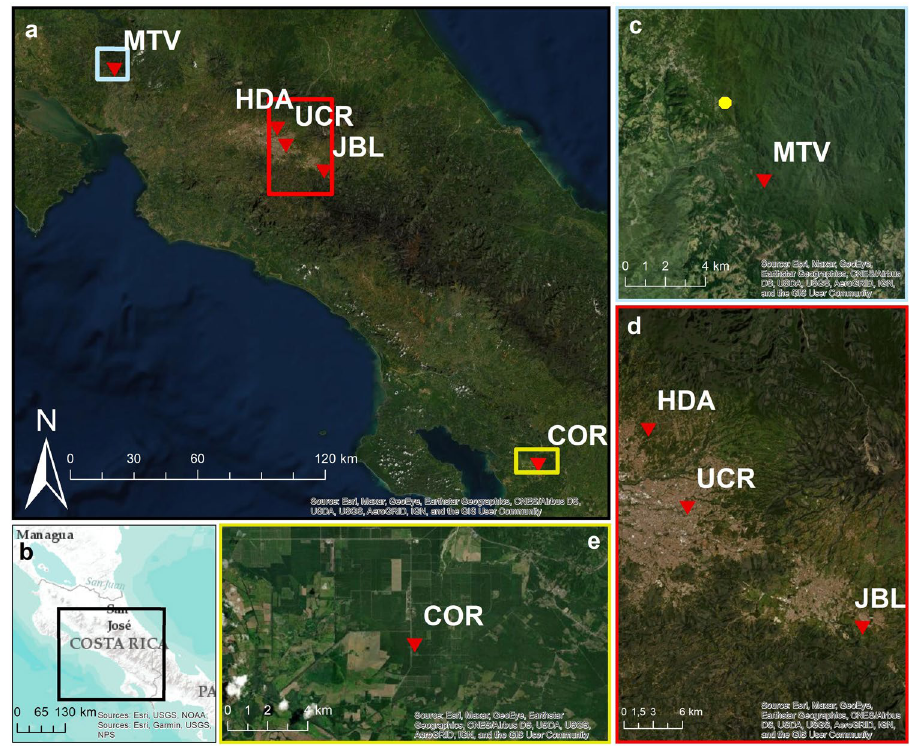
Figure 6. Satellite images of the sampled locations (red down triangle). ( a ) Satellite map showing all sampling sites. ( b ) Our study was located in Costa Rica, Central America. ( c ) MTV sampling site. Yellow dot corresponds to the MTV sampling location for white-eared ground-sparrow. ( d ) HDA, UCR, and JBL sampling sites, located within the Great Metropolitan Area. ( e ) COR sampling site. MTV Monteverde, HDA Heredia, UCR University of Costa Rica, JBL Lankester Botanical Garden, COR Corredores. Images base map source: Esri, Maxar, GeoEye, Earthstar Geographics, CNES/Airbus DS, USDA, USGS, AeroGRID, IGN, Garmin, NOAA, NPS, and the GIS User